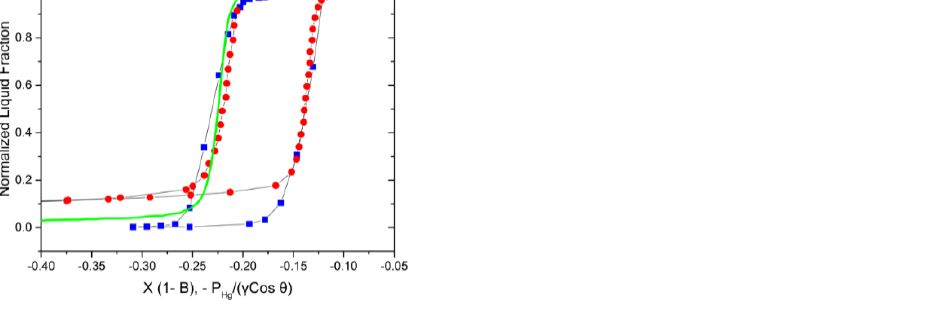
Figure 5. Comparison of nitrogen sorption isotherms (red circles), NMR water cryoporometry transitions (blue squares), and mercury intrusion (green line) data of a controlled porous glass of mean pore size ≈ 12.8 nm .